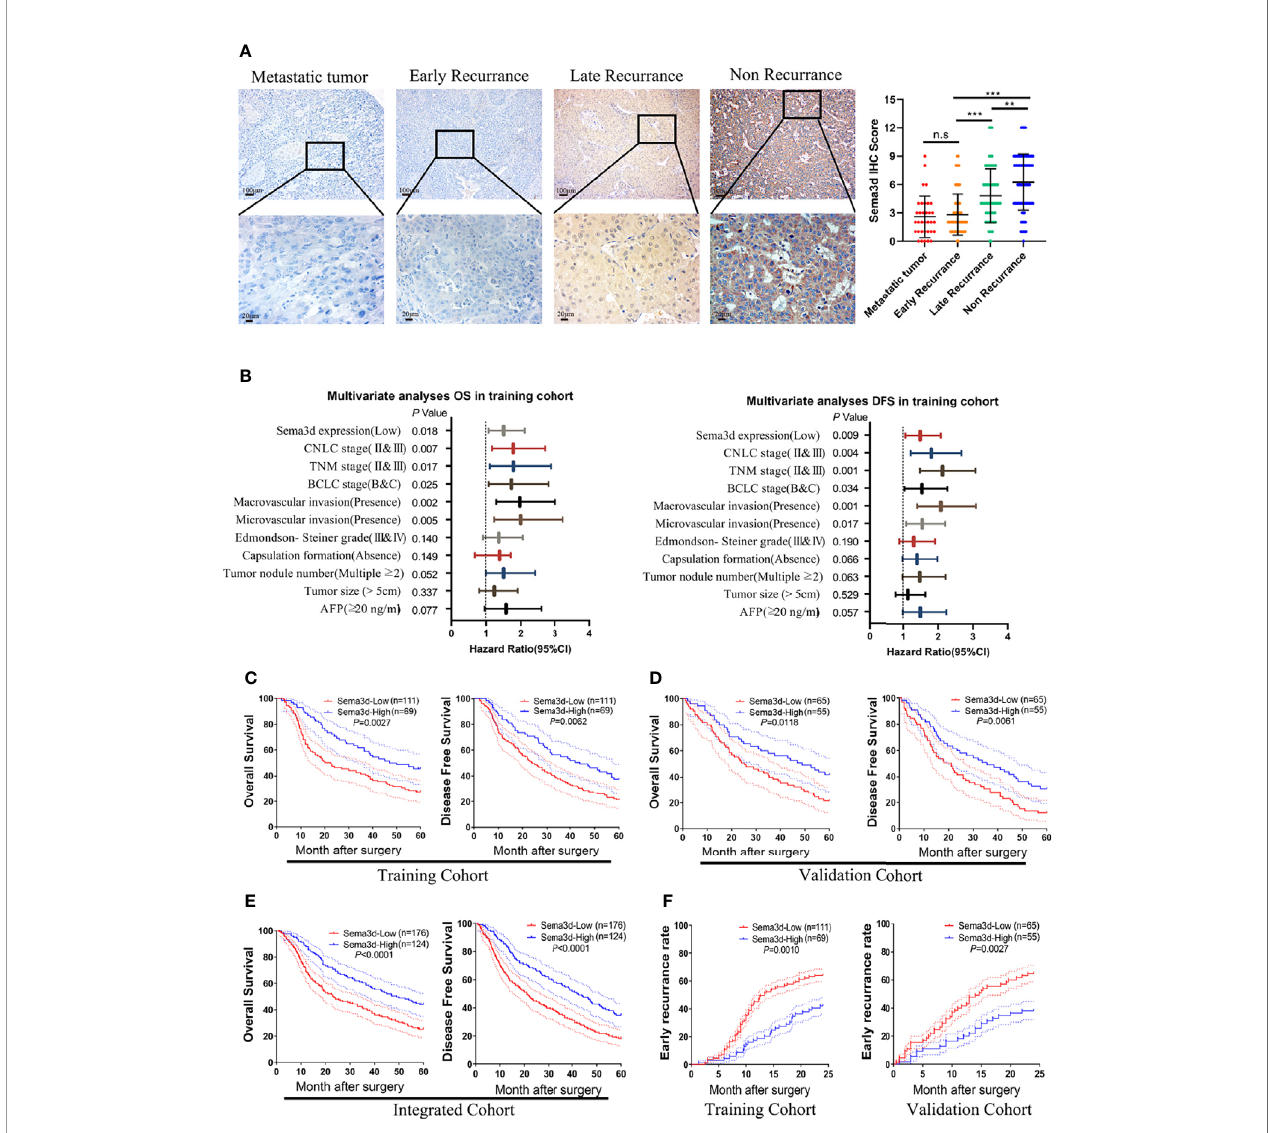
FIGURE 2 | Downregulated Sema3d is associated with HCC ’ s poor prognosis. (A) Representative IHC staining for Sema3d in metastatic tumor ( n = 34), early recurrence of HCC ( < 2 years, n = 142), late recurrence of HCC ( > 2 years, n = 66), and nonrecurrence of HCC (5 years, n = 92). IHC staining score of Sema3d in the integrated cohorts (composed of training and validation cohorts). p -values were calculated by the Mann – Whitney U test. ** p < 0.01; *** p < 0.001. n.s, no signi fi cance. (B) Multivariate analysis revealed that low Sema3d expression was an independent risk factor for overall survival (OS) and disease-free survival (DFS) in the training cohort. (C) Survival analysis for the training cohort reveals the Sema3d-low group had worse OS and DFS. (D) Survival analysis for the validation cohort veri fi ed that the Sema3d-low group had worse OS and DFS. (E) Survival analysis for integrated cohort (composed of training and validation cohorts) veri fi ed that the Sema3d-low group had worse OS and DFS. (F) Kaplan – Meier curves for the cumulative early recurrence ( < 2 years) rate of HCC patients based on Sema3d expression in training and validation